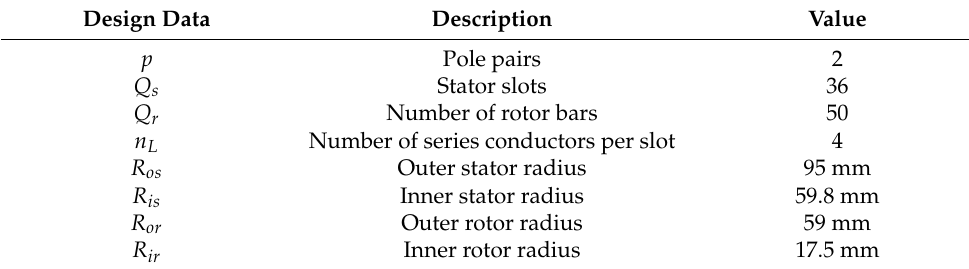
Figure 1. Main geometrical details of initial design D1 ( left ) and prototype view of the hairpin winding ( right ) (courtesy of Tecnomatic S.p.A.). Table 3. Main design data for reference IM machine (design D1).